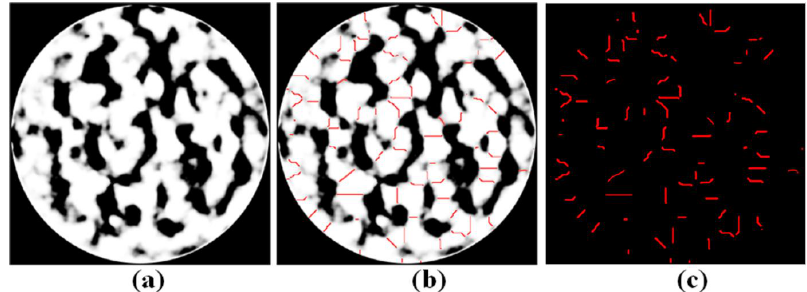
Figure 4. Sintering neck extraction by watershed method: The cross section image ( a ), the result of watershed algorithm ( b ), and the extracted sintering necks ( c